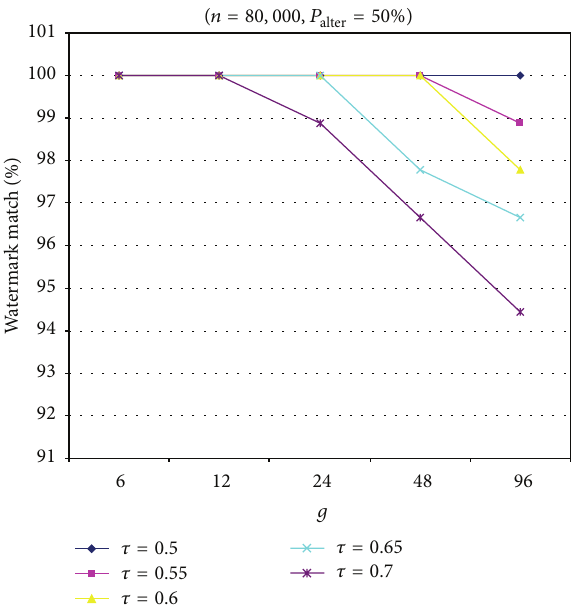
Figure 6: Resilience to the mix-match